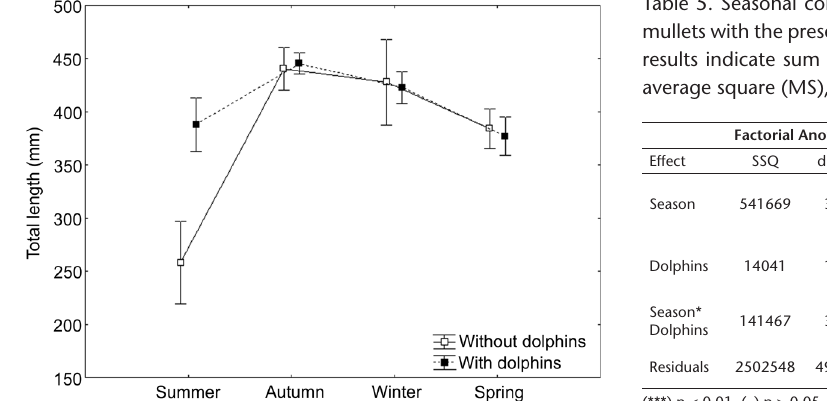
Figure 18. Seasonal variation in total length (mean and standard de- viation) of Mugil liza caught in the presence or absence of dolphins.